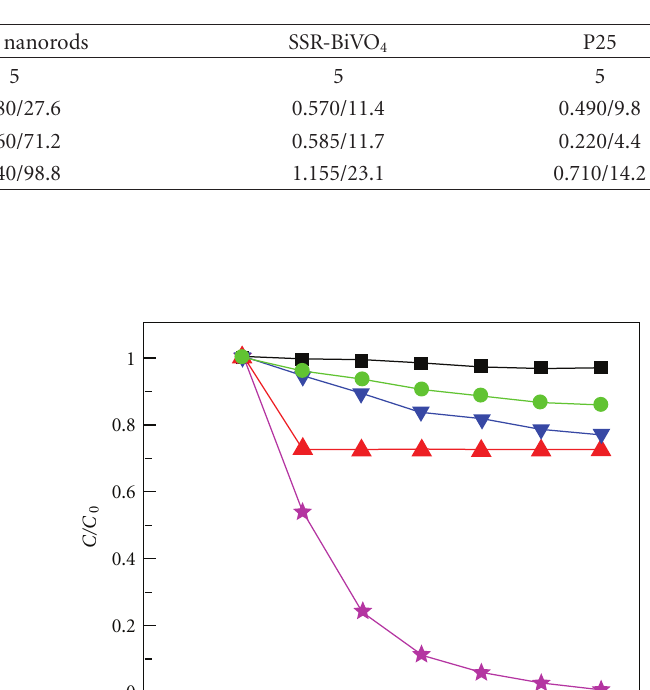
Table 2: Preliminary test for the adsorption and degradation performances of MB on mesoporous BiVO 4 , nanorods, SSR-BiVO 4 and P25, respectively.